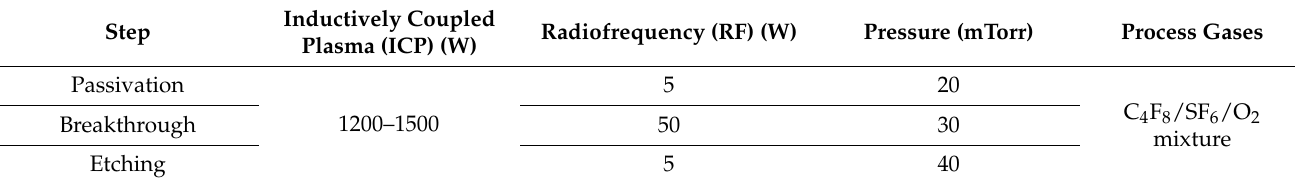
Table 1. Deep reactive ion etching (DRIE) parameters of the used recipe in this